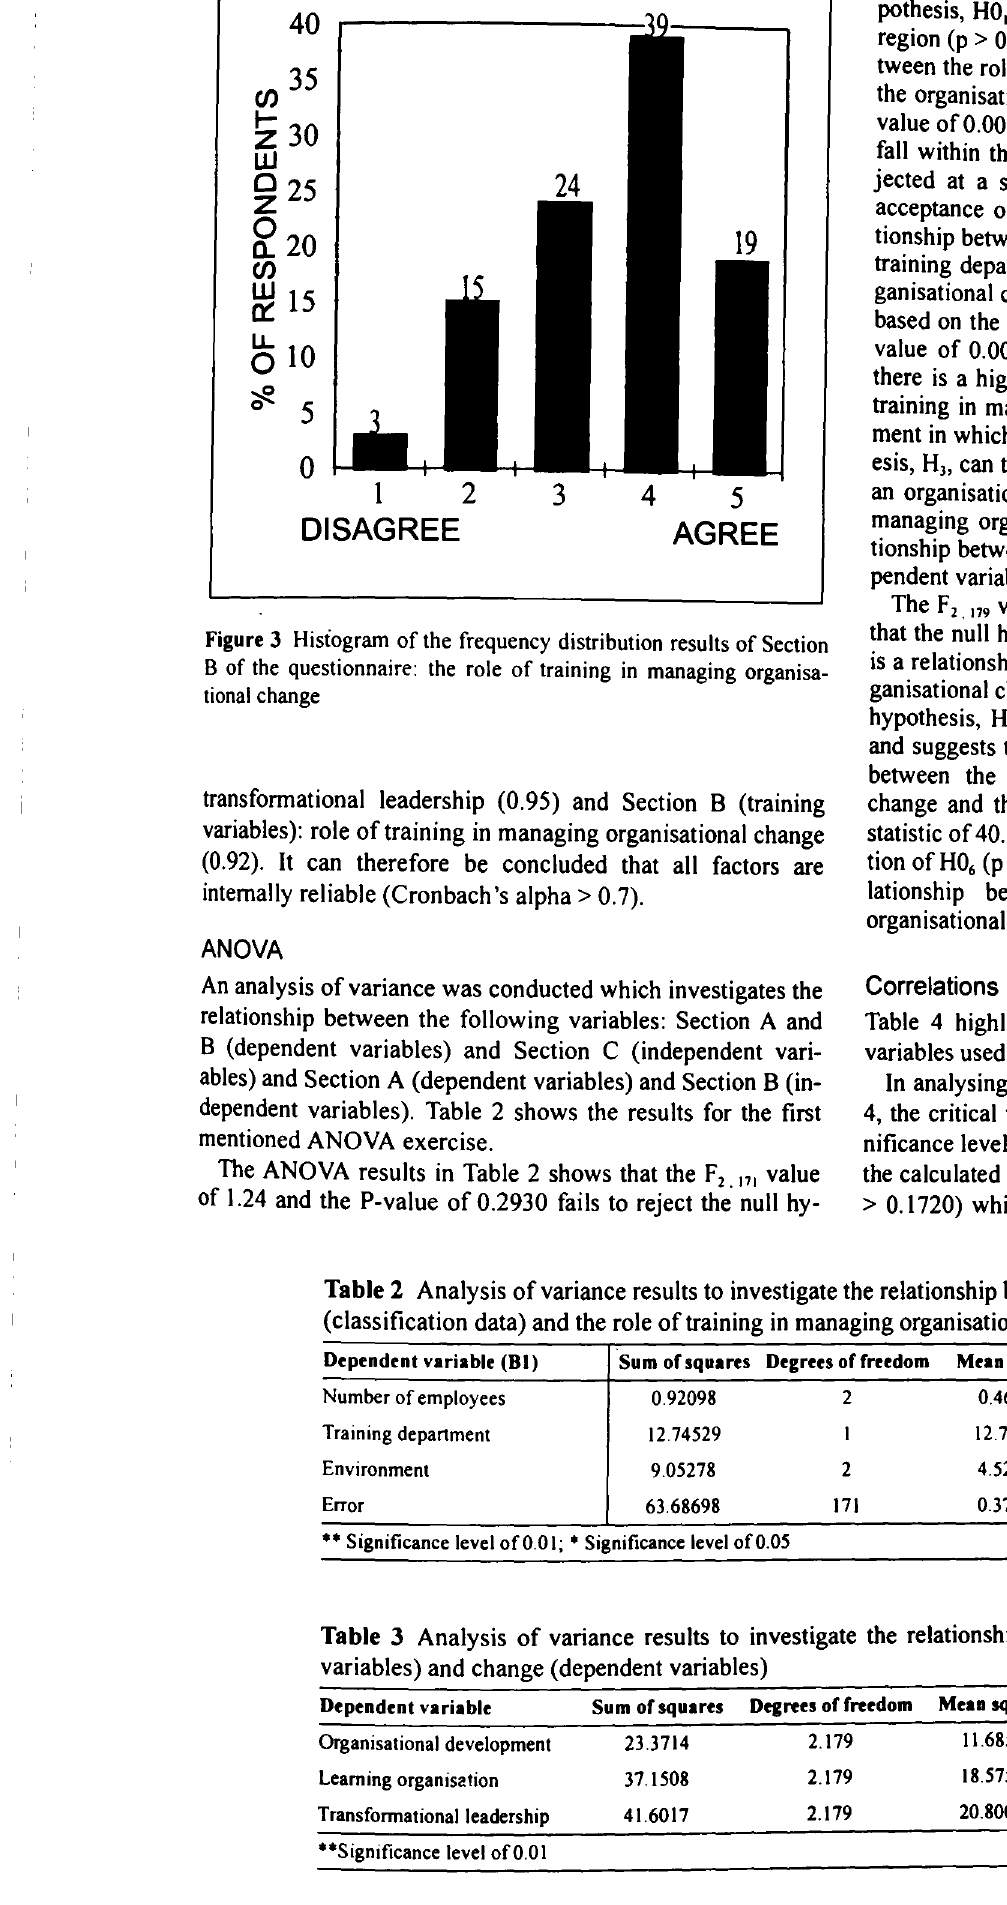
Table 3 Analysis of variance results to investigate the relationship between training (independent variables) and change ( dependent